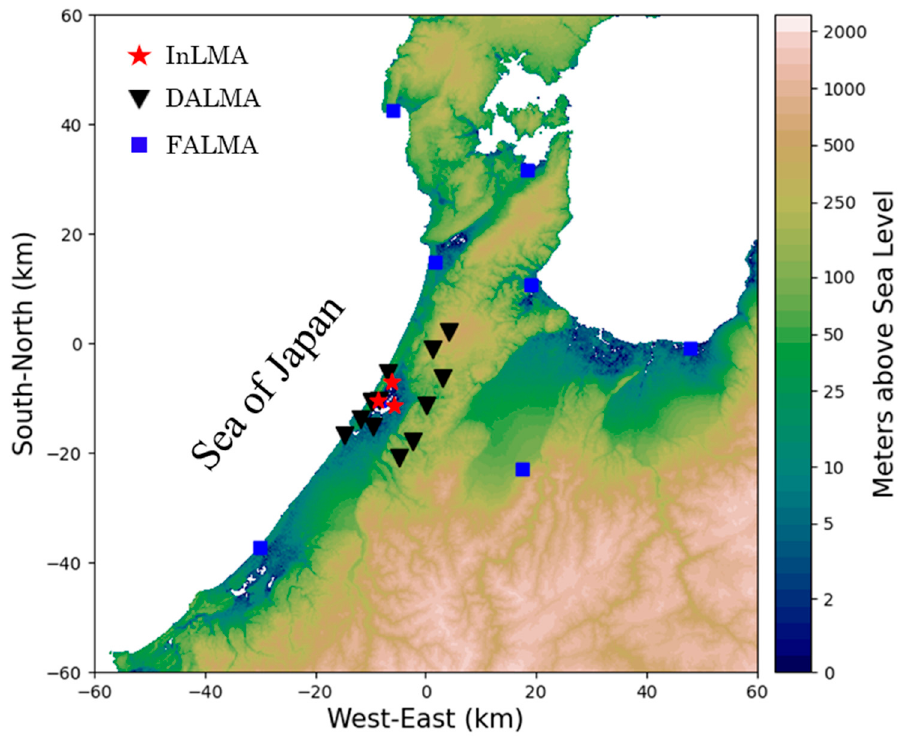
Figure 2. Antenna site map of InLMA, DALMA, and FALMA with the filling color representing the height above sea level.